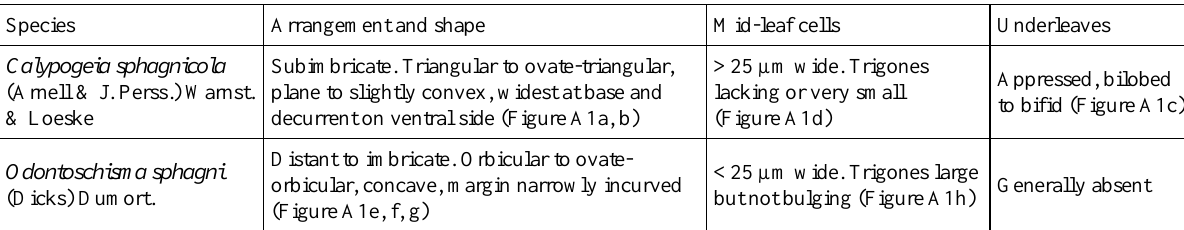
Figure A1. Liverworts. Calypogeia sphagnicola : a) fragment of stem, ventral aspect, b) leaves, c) underleaf, d) medium leaf cells; Odontochisma sphagni : e) stem apex, dorsal aspect, f) flagelliform stem fragment, lateral aspect, g) leaves, h) medium leaf cells. Table A1. Diagnostic characteristics for liverworts: stems and leaves (Figure